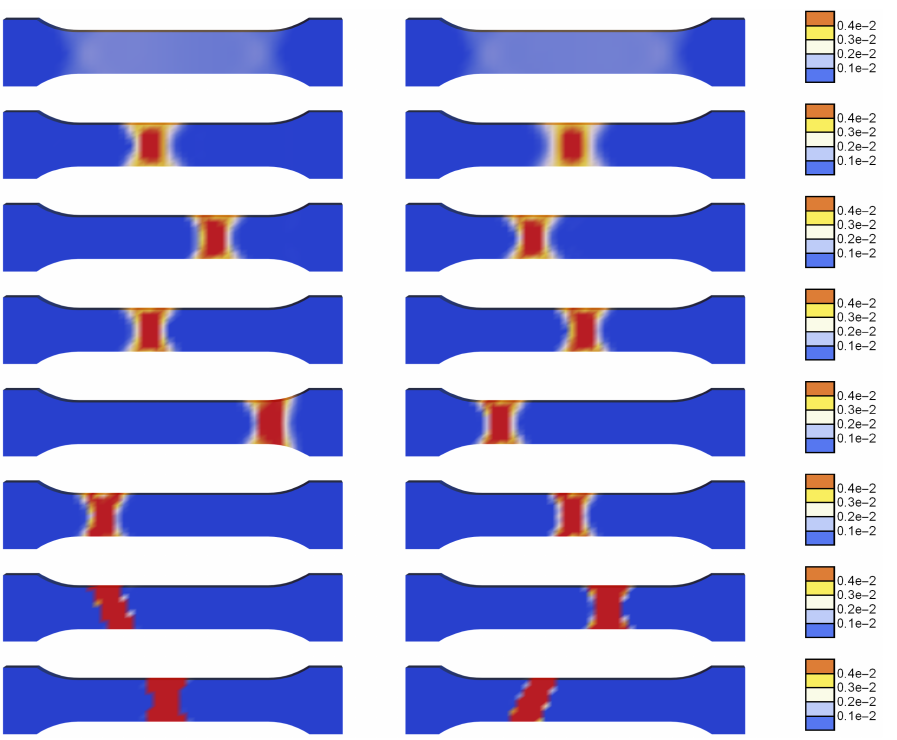
Figure 12. Distributions of ˙ γ at selected states in the deformation history for l = 0 ( left column ) and l = 20 mm ( right column ). For the rows of figures from top ∆ L / L is equal to 3, 5, 7.5, 10, 12.5, 15, 17.5, 20.